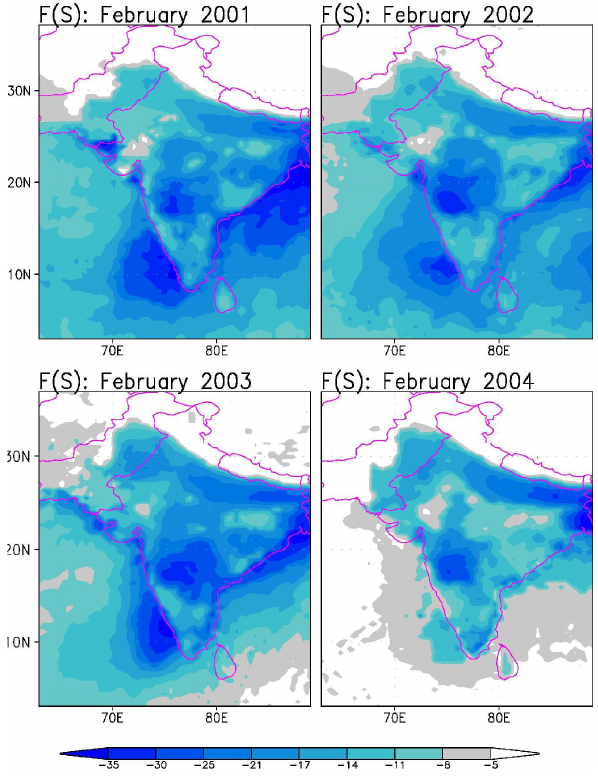
Figure 12. Anthropogenic aerosol forcing at the surface in units of Wm − 2 . Fig. 12. Anthropogenic aerosol forcing at the surface in units of Wm − 2